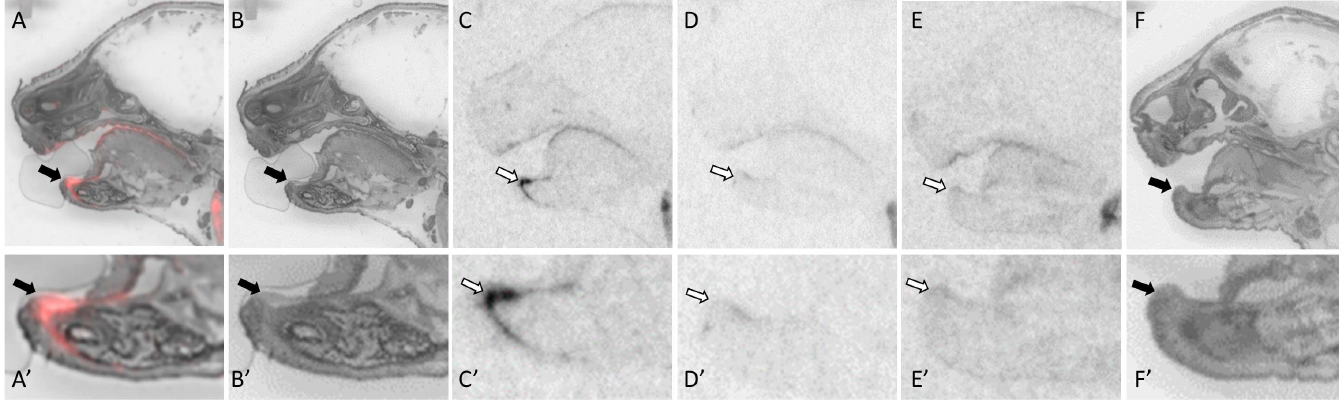
Fig 1. OXTR ligand binding in the primordial tooth of a P0 male mouse. Pseudo-colorcomposite (OXTR in red, cresyl violet counterstain in gray) (A), followedby cresyl violet counterstain (B), with black arrows indicating regionof interest. OXTR ligandbindingis indicatedby white arrows in the 0 nM OXT competition(C), followedby 1000 nM OXT competing with OVTA radioligand to reduce the signal (D). OXTR ligandbindingwas not present in OXTR KO mice (E), followedby the post-processed cresyl violet tissue of the OXTR KO (F).